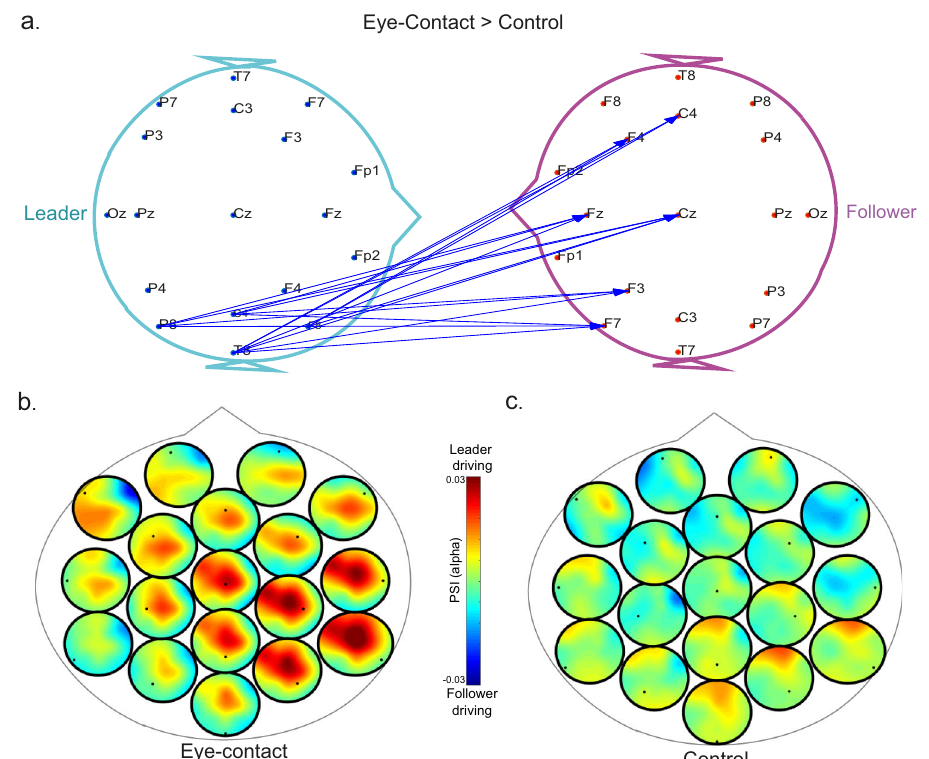
Fig. 5 Directed phase synchronization cluster during eye contact between leaders and followers. a Signi fi cant cluster connections from leader (left) to follower (right) in the alpha band. b Heads-in-head representation of the directed connectivity during eye-contact. Each dot represents the channel of the leader in relation to the follower. Red colours mean the channel is driving that area of the follower. For example, the right parietal electrode (P8) seems to be driving the activity of frontal and midfrontal of the follower (represented in red). c The same representation as in b but during the control